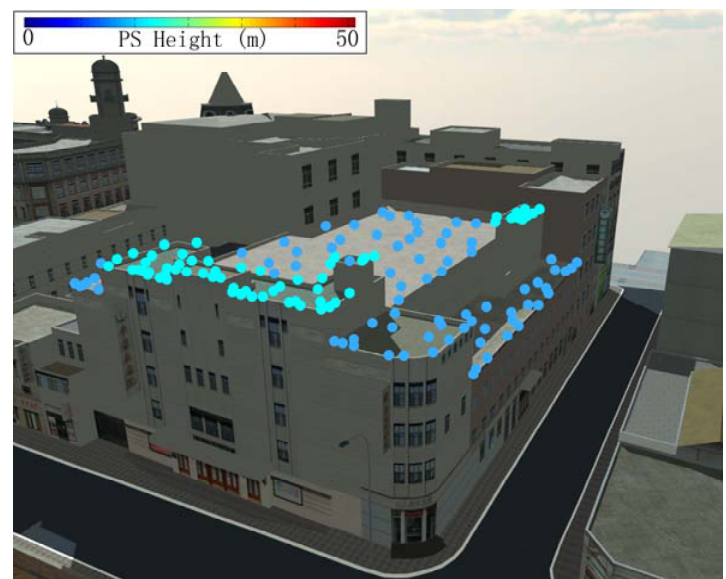
Figure 4. Three ‐ dimensional representations of extracted PS point geocoded on precise models for the China Theater. All the PS satisfying the stability criteria during IPTA processing (sub ‐ correlation coefficient larger than 0.35 and amplitude deviation measure larger than 1.4) have been located on roof, in the monitoring period from May to December 2014.